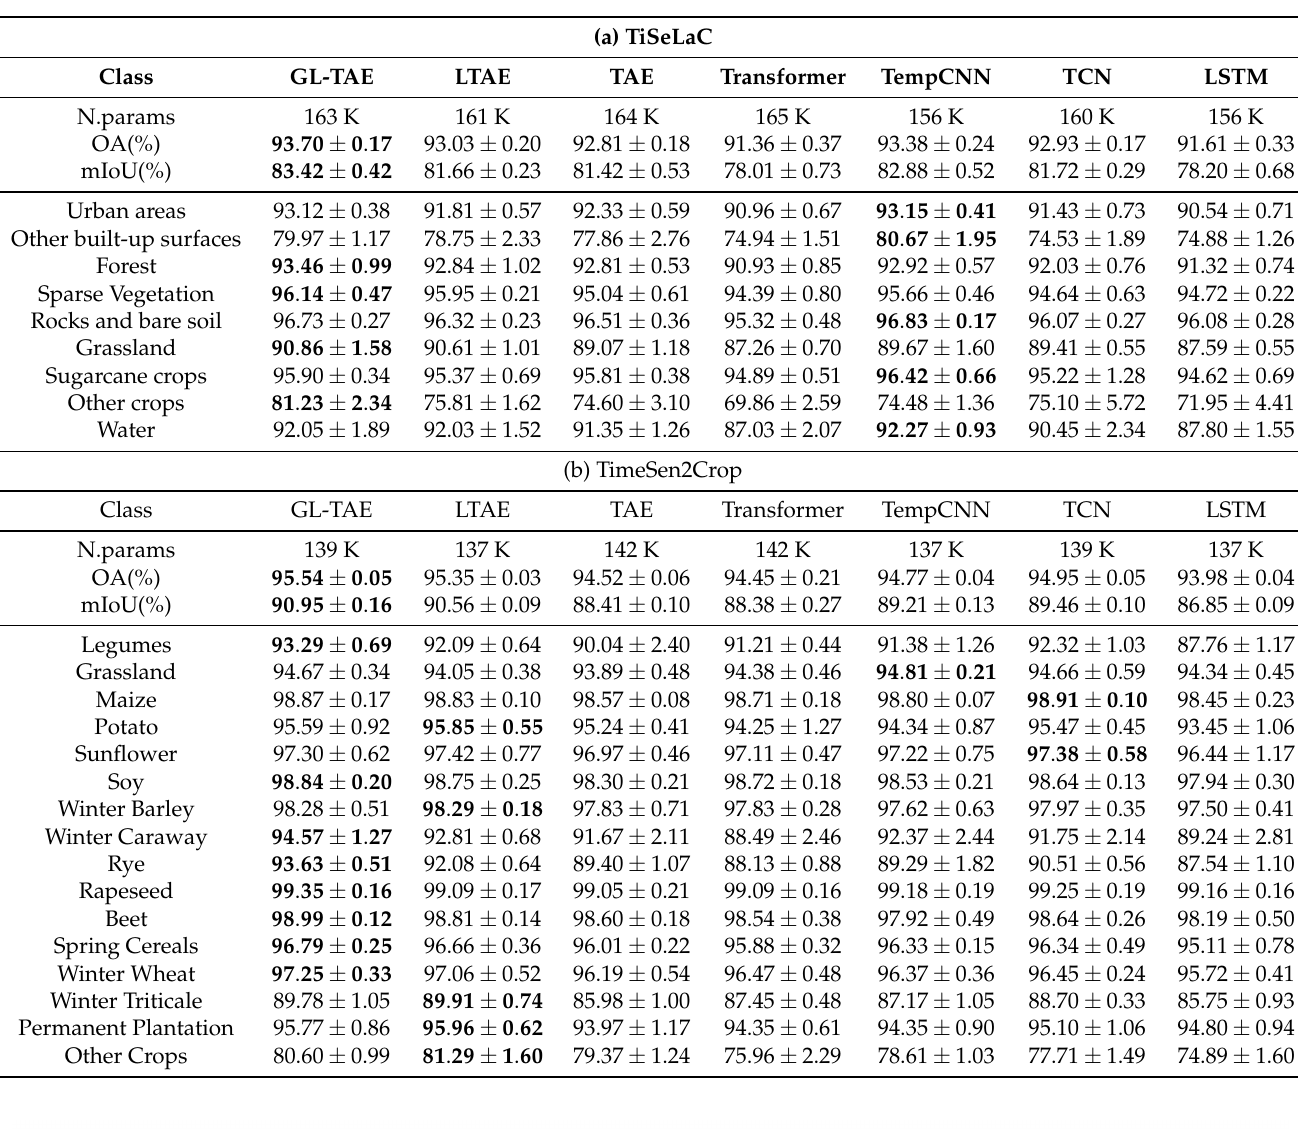
Table 4. Performance of GL-TAE and competing models all having approximate 160 K parameters on (a) TiSeLaC/140 K parameters and (b) TimeSen2Crop.